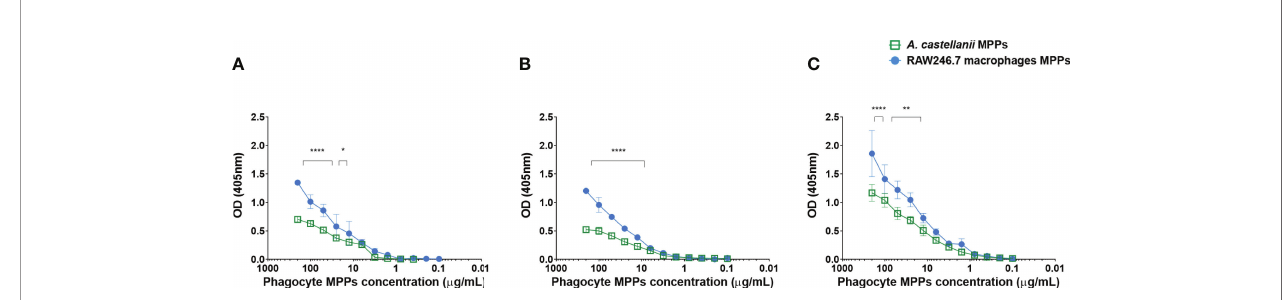
FIGURE 3 | Acanthamoeba castellanii and macrophages mannose-puri fi ed proteins (MPPs) showed a dose-dependent binding to fungi. Indirect ELISA to analyze the binding of MPPs of A. castellanii and RAW 264.7 macrophages to (A) Candida albicans , (B) Cryptococcus neoformans and (C) Histoplasma capsulatum . (*p < 0.05; **p < 0.001 and ****p <